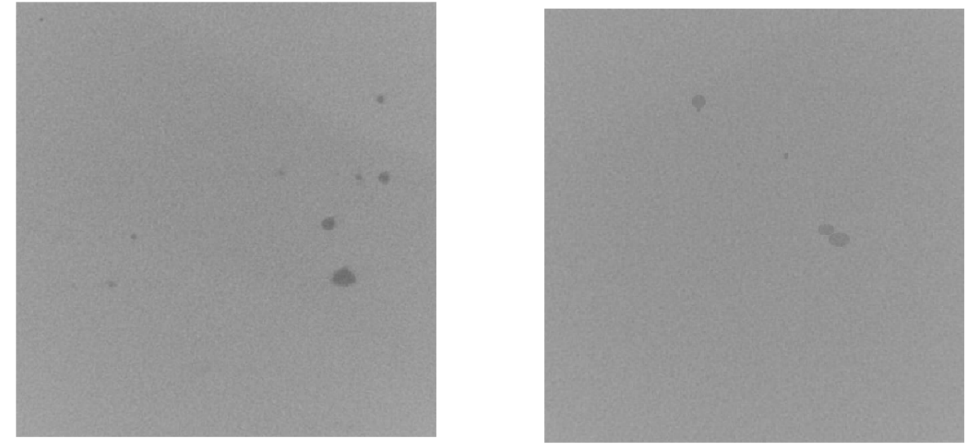
Figure 20. Real image ( Left ) vs. final version of artificial image ( Right ).